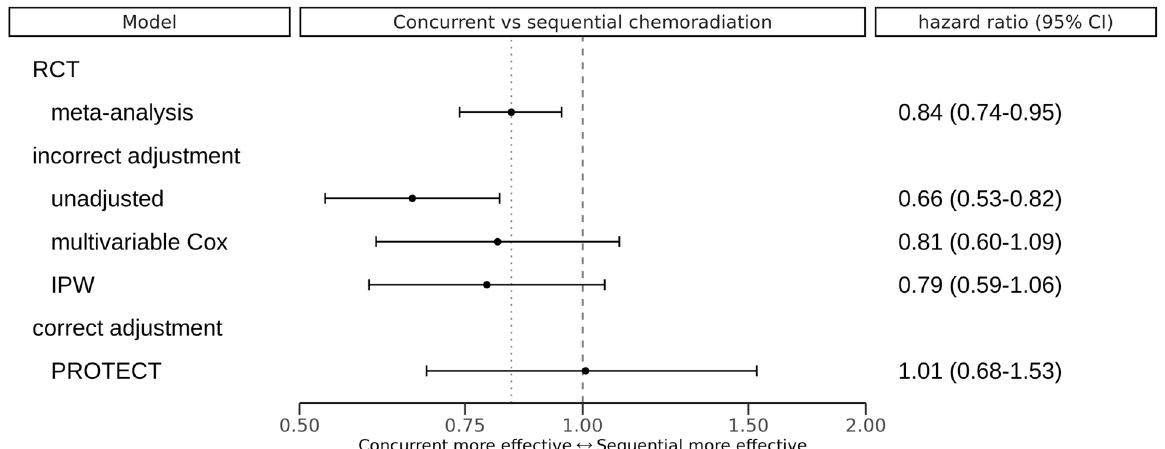
Figure 3. Overview of treatment effects estimated with different methods. The dashed vertical reference line indicates the null effect (hazard ratio of 1), the dotted reference line indicates the point estimate of the meta- analysis of RCTs by Aupérin et al. 6 . IPW inverse-probability of treatment weighted Cox-proportional hazards model. PROTECT proxy based individual treatment effect modeling in cancer, CI confidence interval, for PROTECT credible interval; RCT randomized controlled